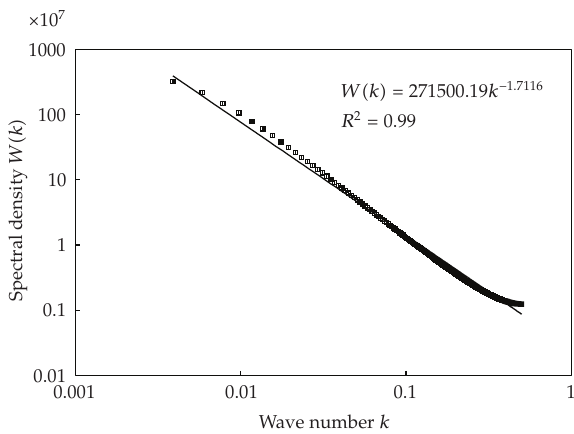
Figure 3: A log-log plot of a wave-spectrum relation based on negative exponential function. (cid:3) Note that taking ρ 0 (cid:8) 50000 and r 0 (cid:8) 32 in (cid:3) 2.1 (cid:4) yields a sample path of N (cid:8) 512. A wave-spectrum analysis of this sample gives β (cid:8) 1 . 7116, which suggests that the fractal dimension of the self-a ffi ne record is around D s (cid:8) 1 . 6442. (cid:4)